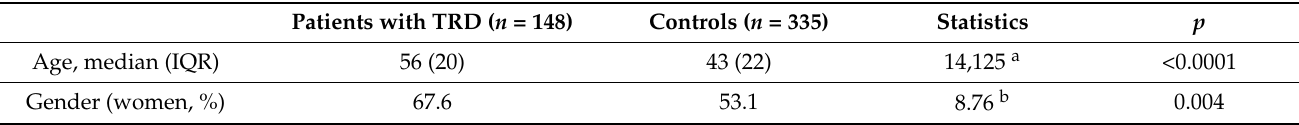
Table 1. Demographic characteristics of the sample.